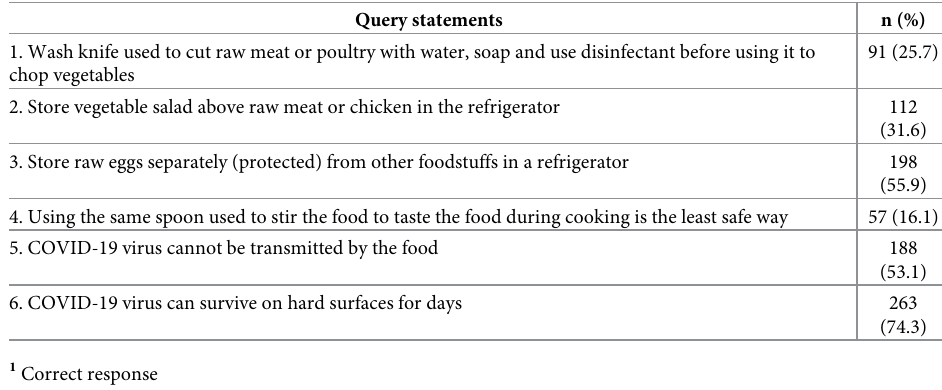
Table 4. Query statements and responses 1 of “cross-contamination prevention” aspect (n =